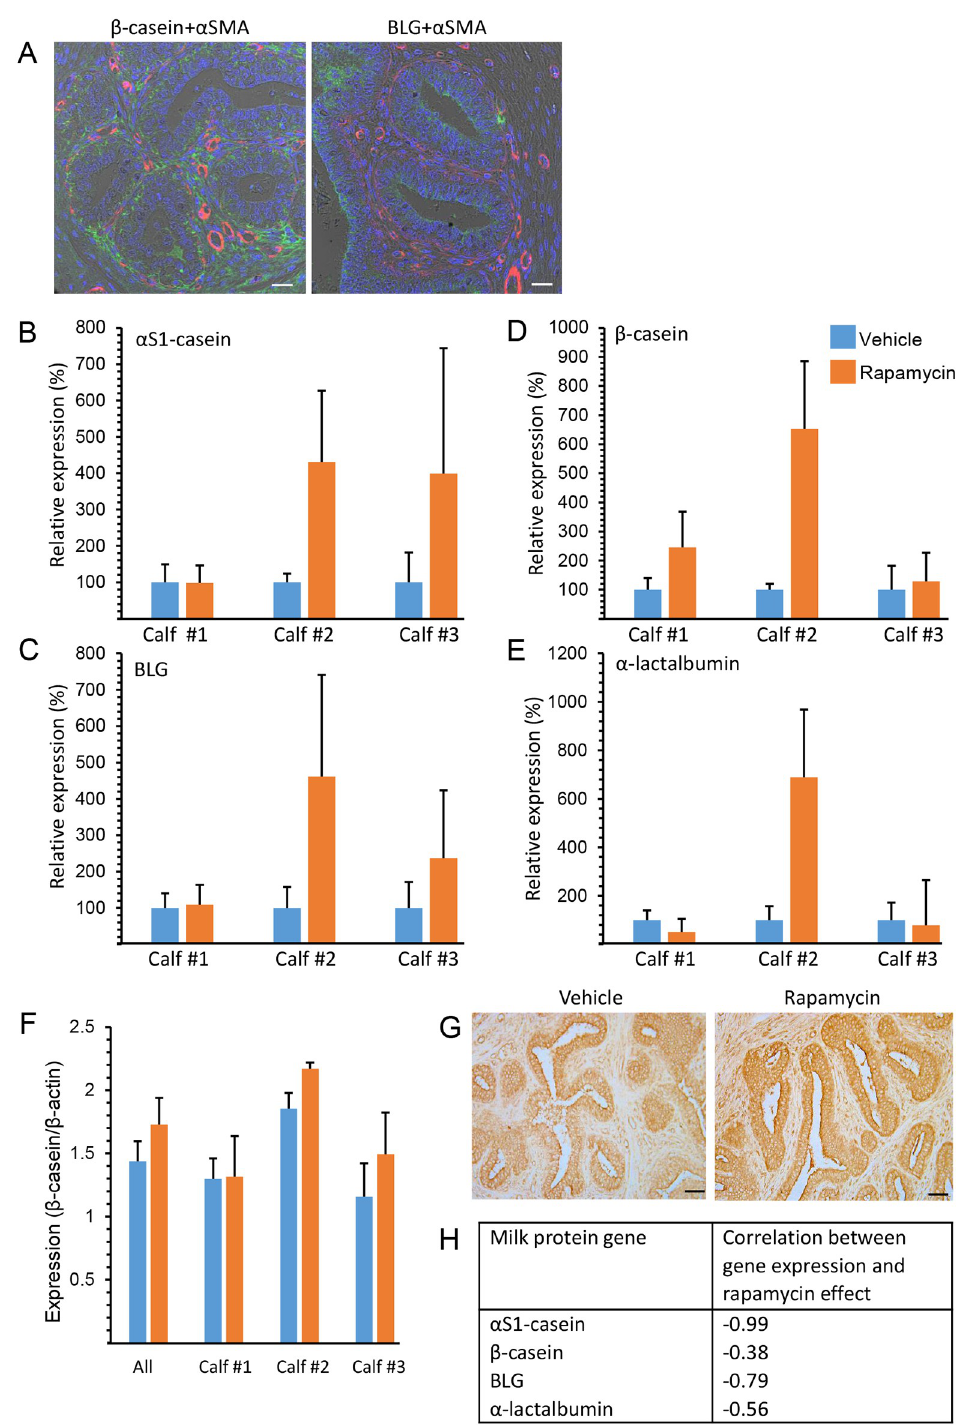
Fig 6. Unequal effects of intramammary rapamycin administration on milk protein gene expression in individual calves. A. Representative immunofluorescence analyses of milk protein expression by luminal cells in the mammary glands of 3-month-old calves. Bar = 20 μ m. B–E. Effect of rapamycin on relative expression of milk protein genes is unequal among calves. Bars represent mean ± range of two glands in each analysis. F. Bar graph representing immunoblot analysis of β -casein expression relative to β -actin expression in the mammary glands of vehicle- and rapamycin-treated glands. Immunoblots are presented in S3 Fig. Bars represent mean ± range of two analyzed glands